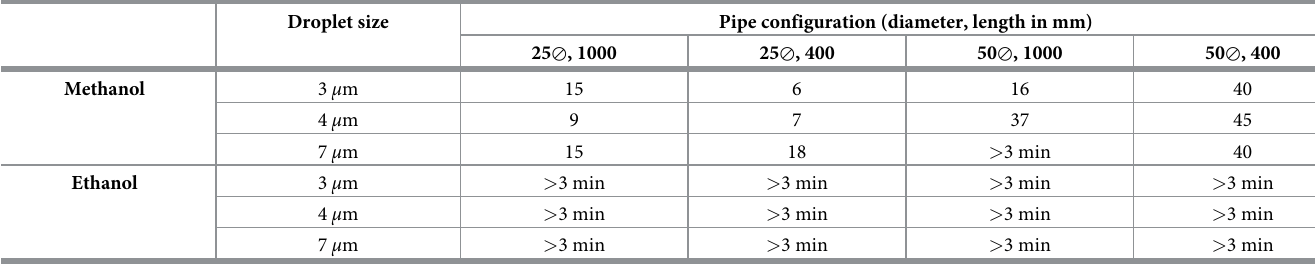
Table 6. t evap in seconds unless otherwise stated as a function of droplet size and pipe type. Droplet